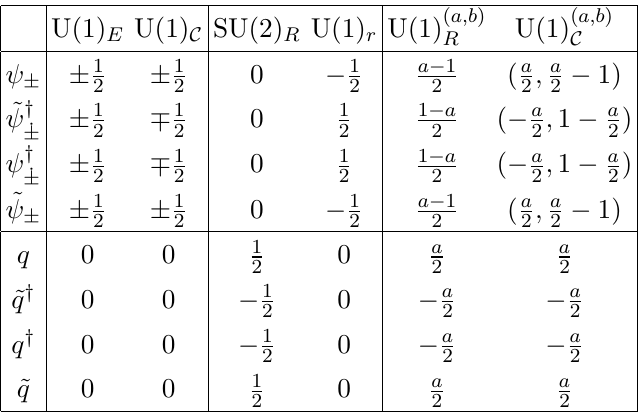
Table 3. Twisting hypermultiplets with both SU(2) R and U(1) r .